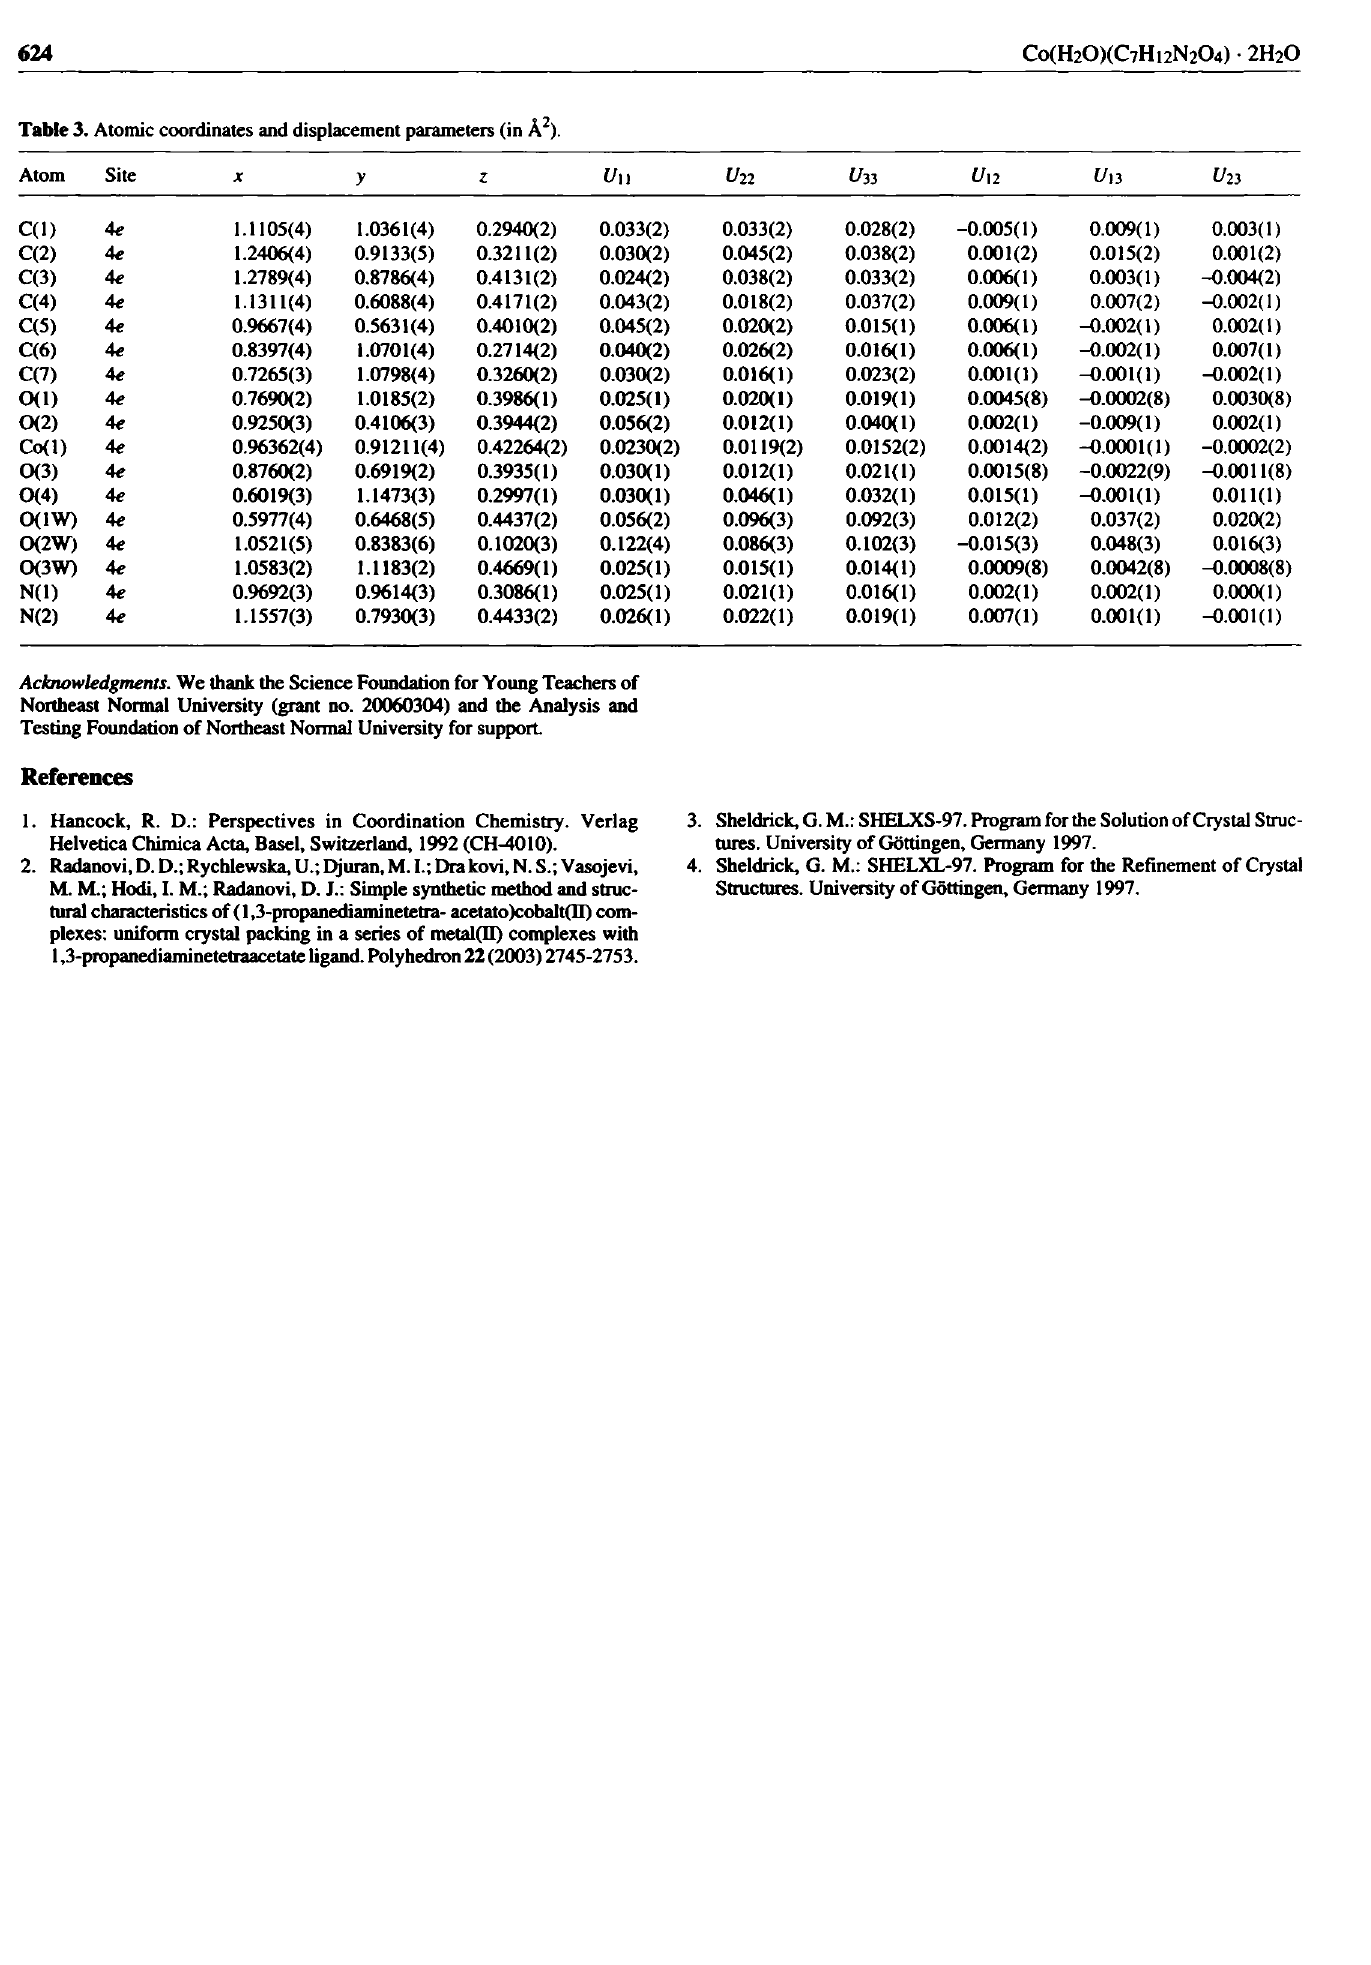
Table 3. Atomic coordinates and displacement parameters (in Â 2